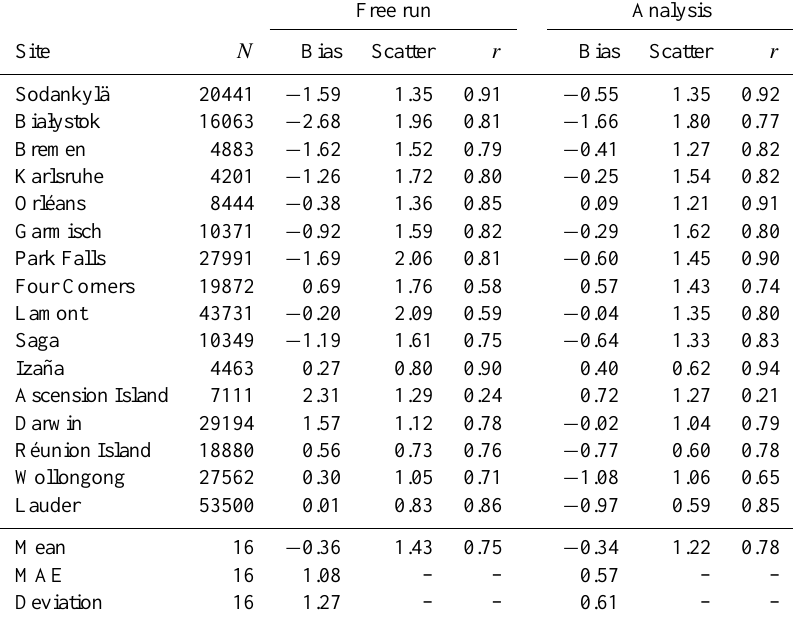
Table 2. Statistics of the XCO 2 difference between the simulations (free run and analysis) and the average hourly TCCON data (model– TCCON): bias ( δ k , in ppm), scatter ( σ k , in ppm) and correlation coefficient ( r k ). Also shown are the mean, the mean absolute error (MAE) and the deviation of the stations bias (respectively δ , (cid:49) and σ , in ppm), the mean scatter ( π , in ppm) and the mean r (last three rows). The second column ( N ) is the number of data used for computing the